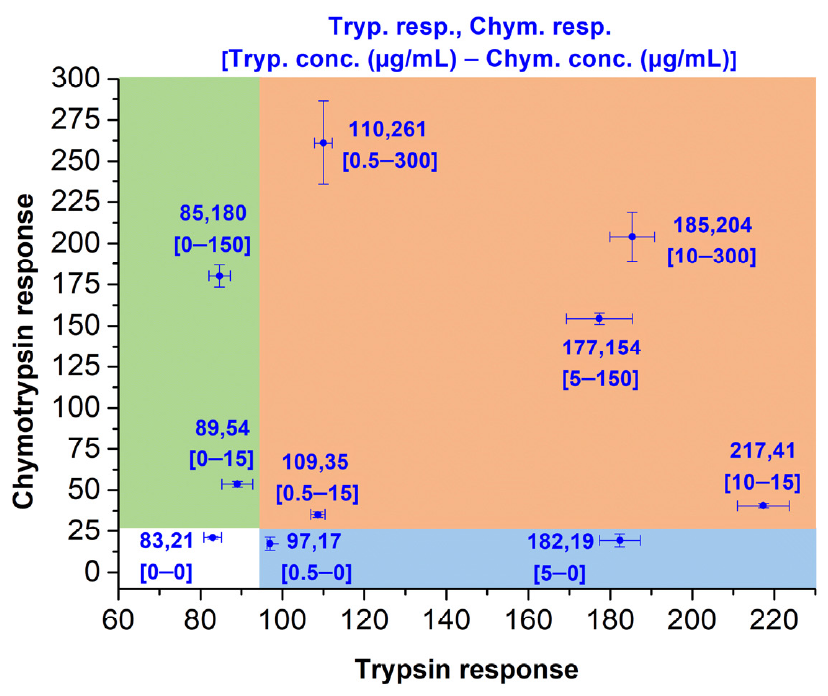
Figure 7. Simultaneous fluorescence-based detection of the trypsin–chymotrypsin pair in various concentration combinations with synchronous usage of ITP and ICP bound to Rink Amide PEGA resin. The immobilized probes (2.0–2.1 mg) were dispersed in Tris-HCl buffer (0.1 M; 1 mL) and incubated for 15 min at 37 °C. Fluorescence emission was measured at 480 nm ( ITP ) and 595 nm ( ICP ) after excitation at 410 nm. Detector voltage was set to 600 V.